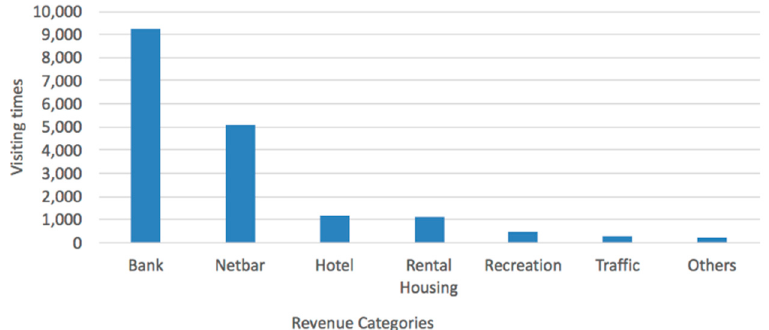
Figure 9. Visiting Intensities of Venue Types.